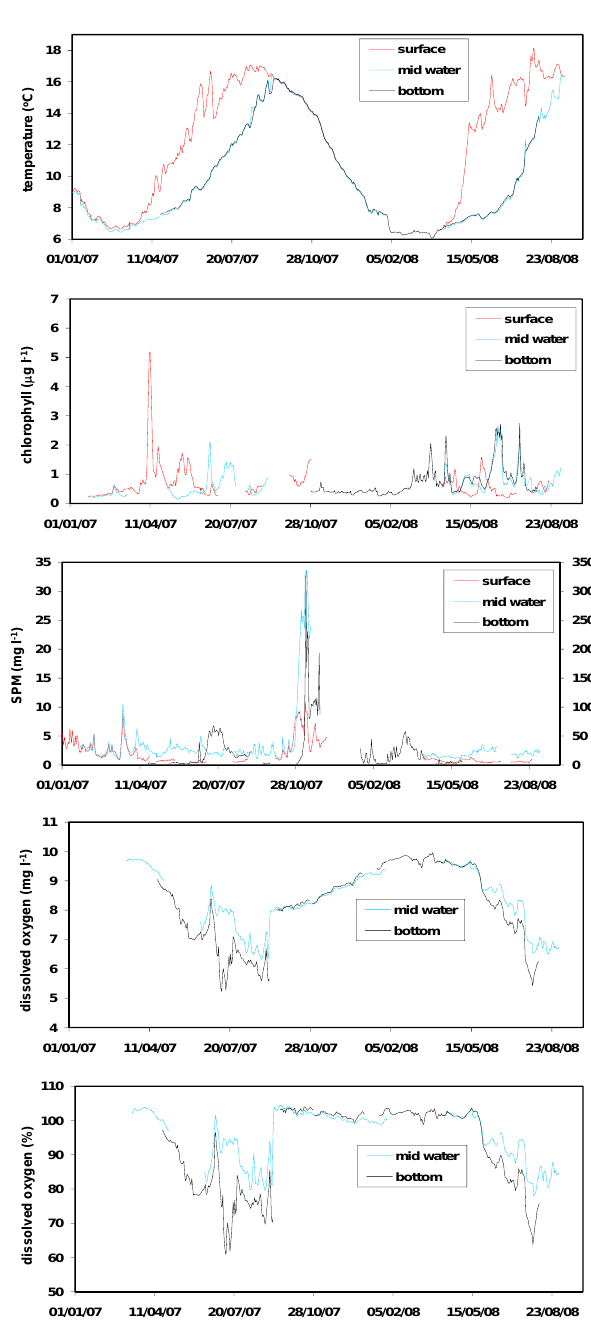
Fig. 2. Mooring data from Oyster Grounds for (a) temperature, (b) chlorophyll, (c) SPM (surface and mid-water on primary y axis, bot- tom on secondary y axis), (d) oxygen concentration and (e) oxygen percent saturation.